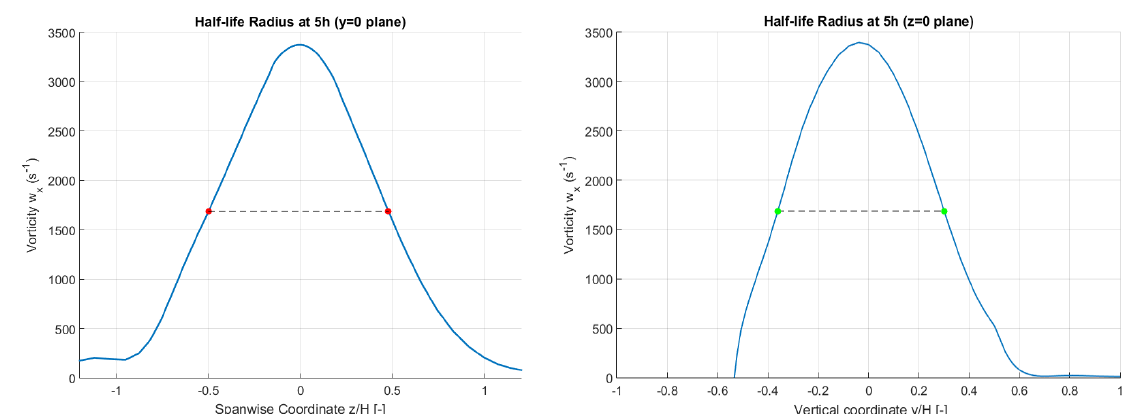
Figure 12. Streamwise vorticity w x distributions for points at the same vertical coordinate as vortex core ( left side) and for points with the same spanwise coordinate as vortex core ( right side ). Red points are those corresponding to the R 05 calculation and green points as new points for the calculations of the new parameter S 05 .